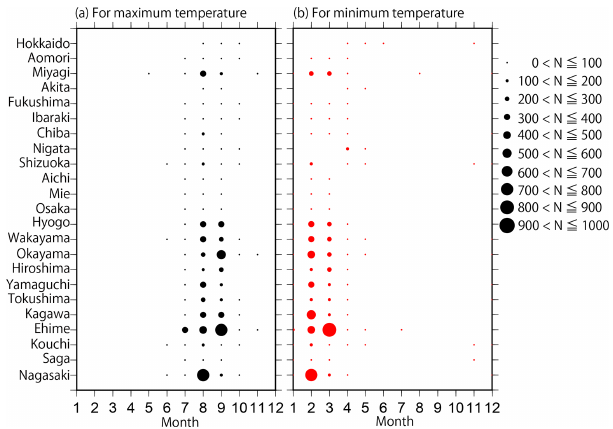
Figure 2. Distributions of the monthly number of data points ( N ) for (a) maximum and (b) minimum temperatures collected in each prefecture from the 302 most reliable monitoring sites. Figure 3. Examples of (a) acidification (Kahoku coast in Ishikawa) and (b) basification (Funakoshi Bay in Iwate) trends at monitoring sites. Blue and red colors indicate the annual minimum and maxi- mum pH insitu data and their trends, respectively.